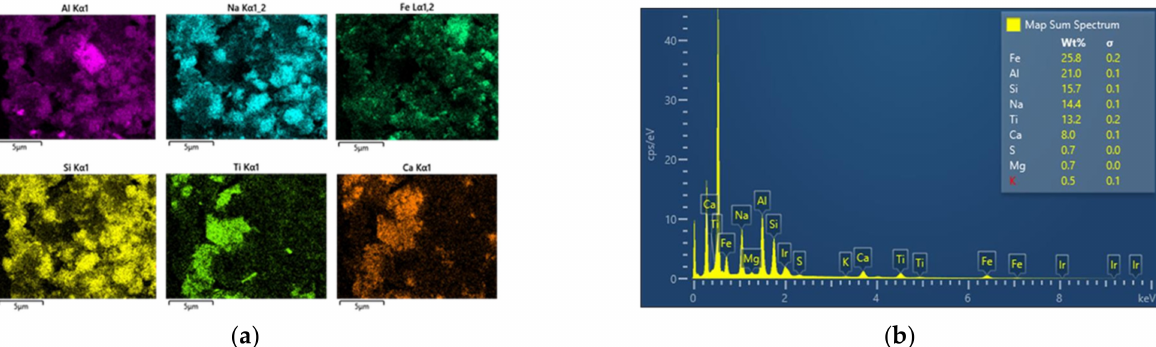
Figure 8. ( a ) SEM Image of BR ETI (20 Kx). ( b ) SEM Image of BR ETI (R200 Kx).